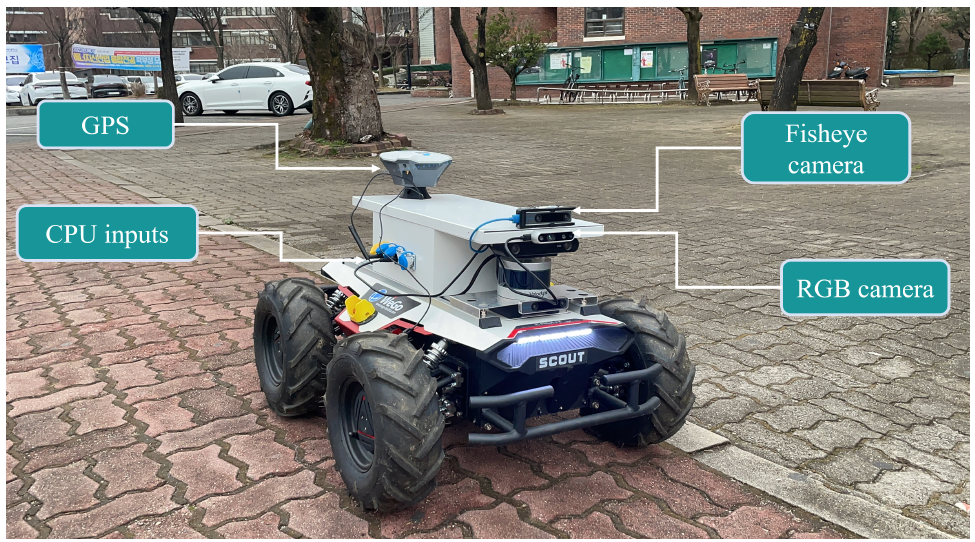
Figure 1. The customized delivery robot